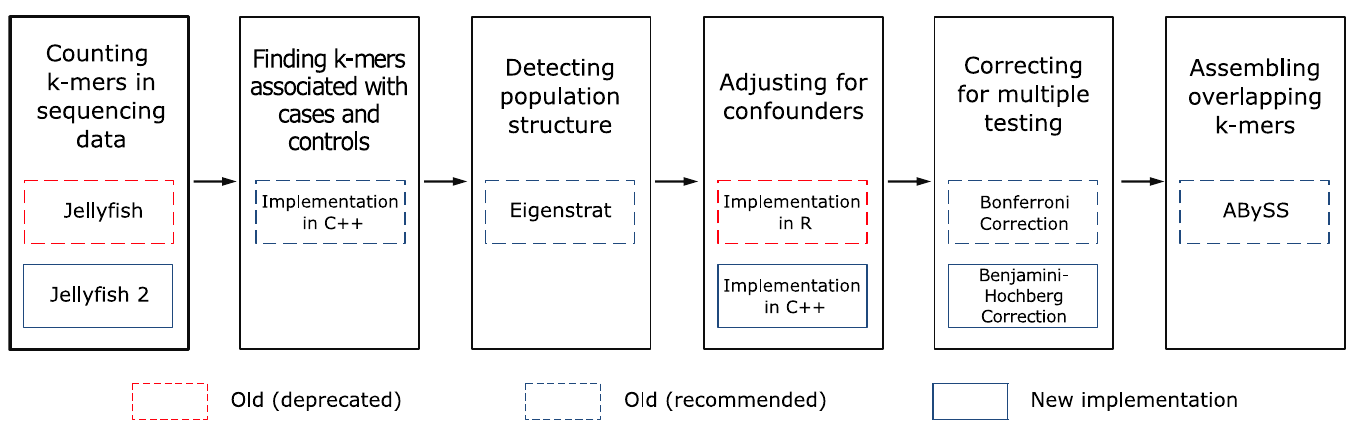
Fig 1. The workflow for the reference free association mapping method H AWK with the new features highlighted. The re-implemented and newly added features are shown within solid blue boxes. Dashed red boxes and dashed blue boxes indicate old implementations that have been deprecated and are still recommended respectively.